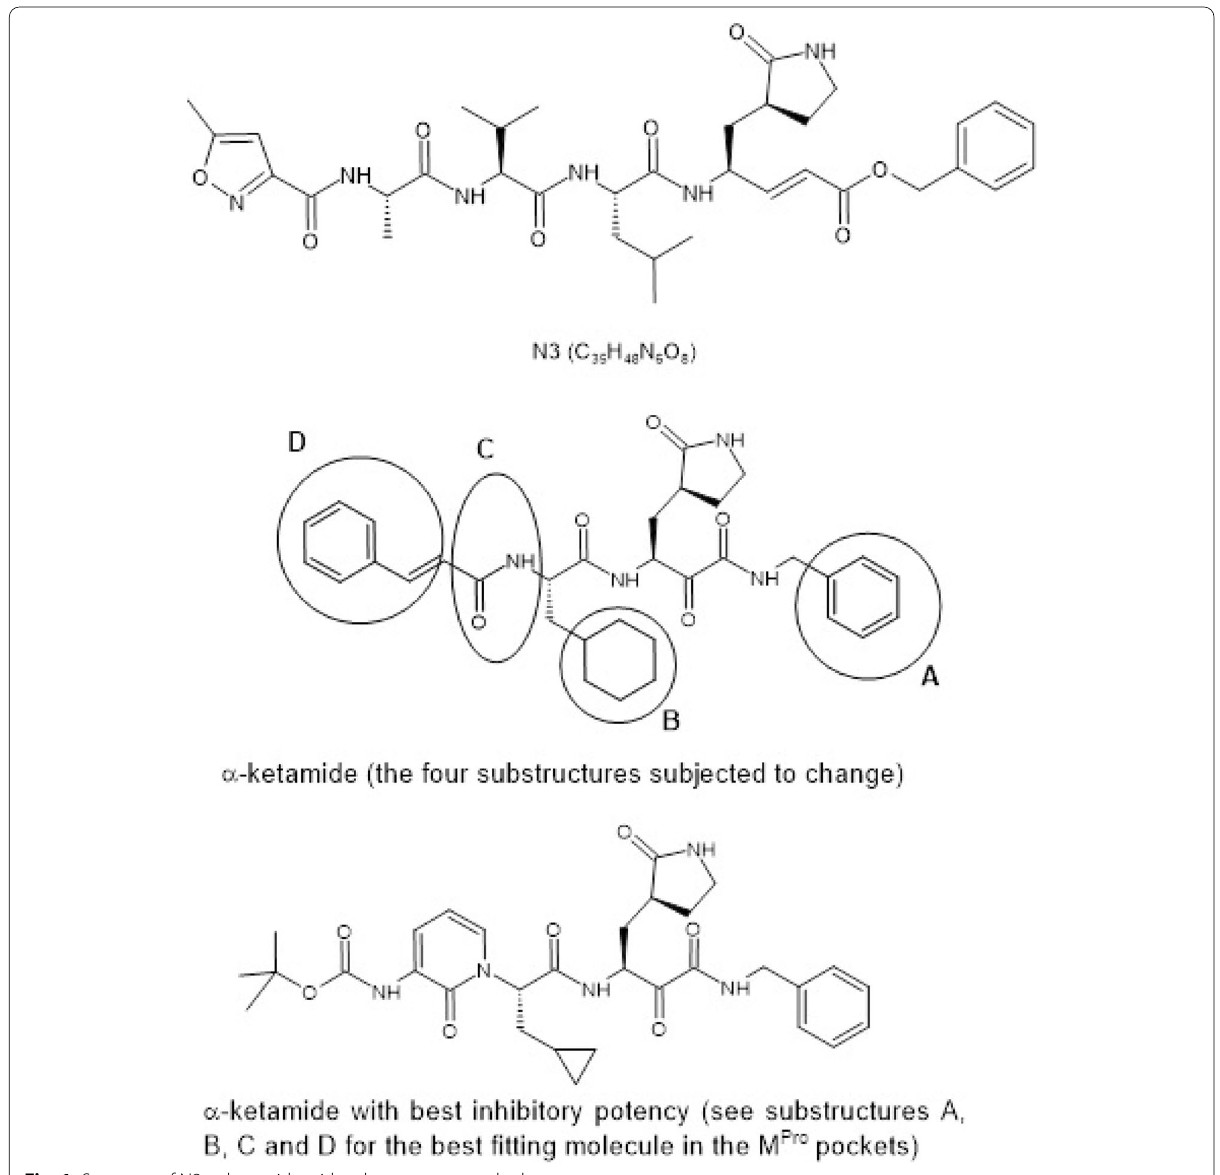
Fig. 1 Structure of N3, α-ketamide with sub-structures